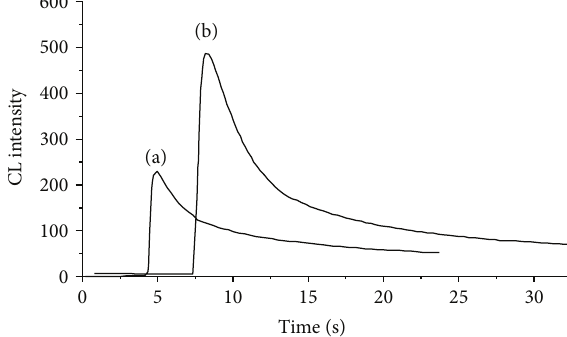
Figure 2: CL kinetic curve of the CL reaction. (a) 8.0 × 10 −5 mol ⋅ L −1 luminol — 4.0×10 −4 mol ⋅ L −1 K 3 Fe(CN) 6 and (b) 8.0×10 −5 mol ⋅ L −1 luminol — 4.0 × 10 −4 mol ⋅ L −1 K 3 Fe (CN) 6 — 2.0 × 10 −6 g ⋅ L −1